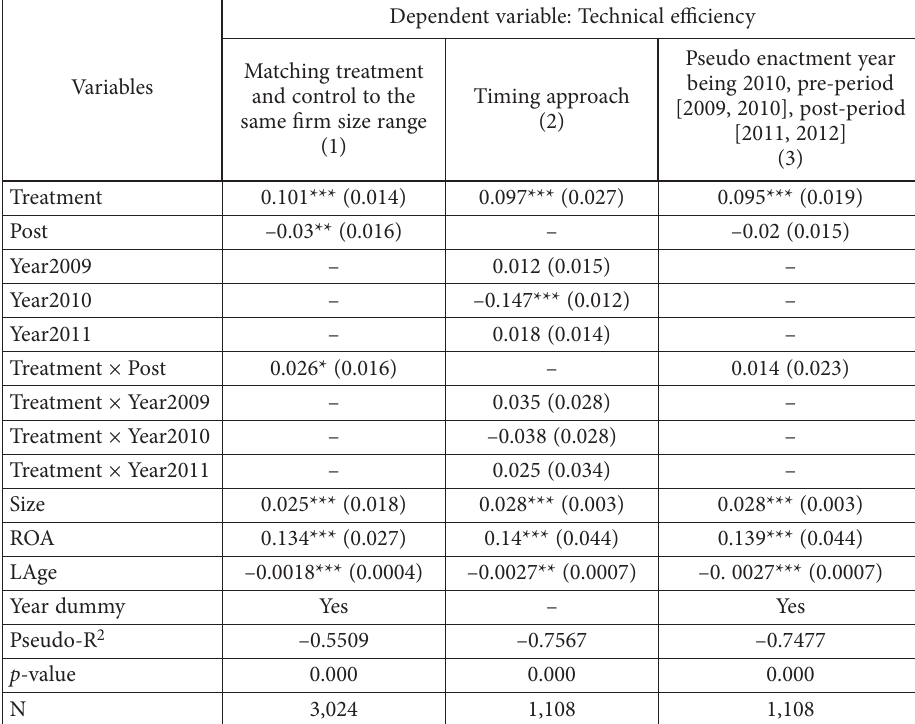
Table 6. Additional analysis for robustness checks (source: author’s